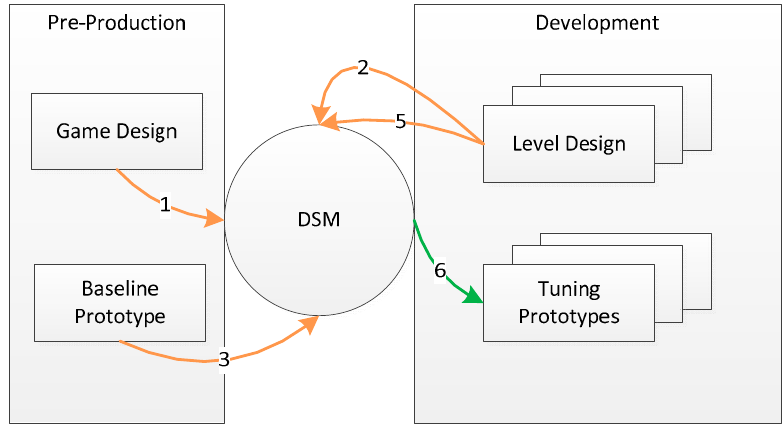
Figure 1. A Domain-Specific Modeling embedded workflow for game development [18].